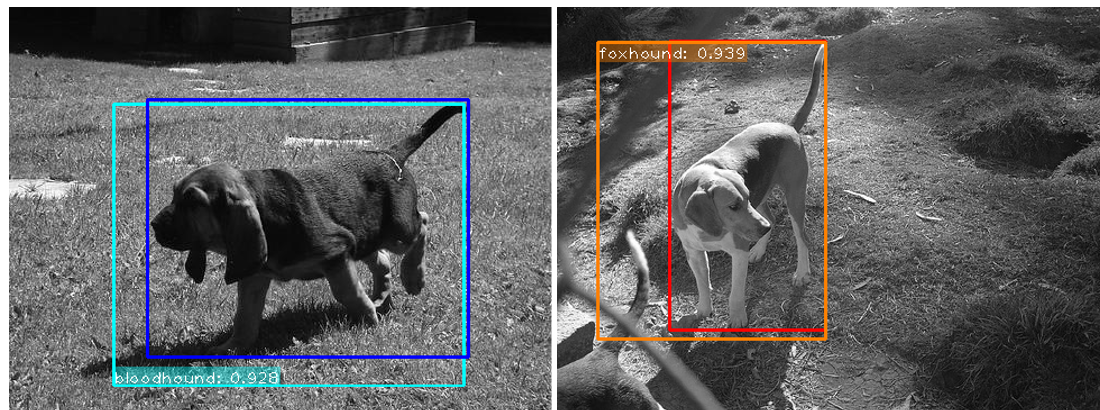
Figure 6. Prediction results from the Stanford Dog images. Image on the right and left are predictions for a Blackhound image and a English Foxhound image,